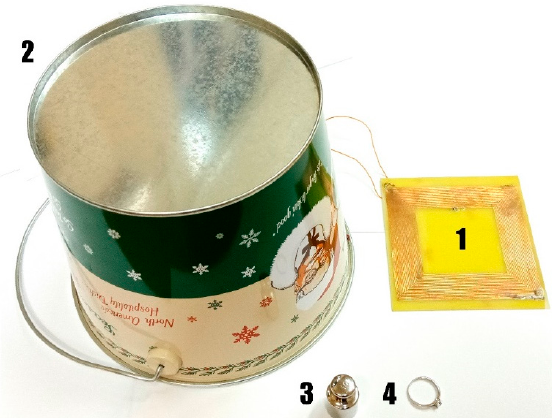
Figure A1. A photograph of targets used in the experiment with respect to the sensing coil (1): round flat bottom of a steel bucket (2), scale weight (3), silver ring (4). Curve in Figure 6 was obtained for the target (2).